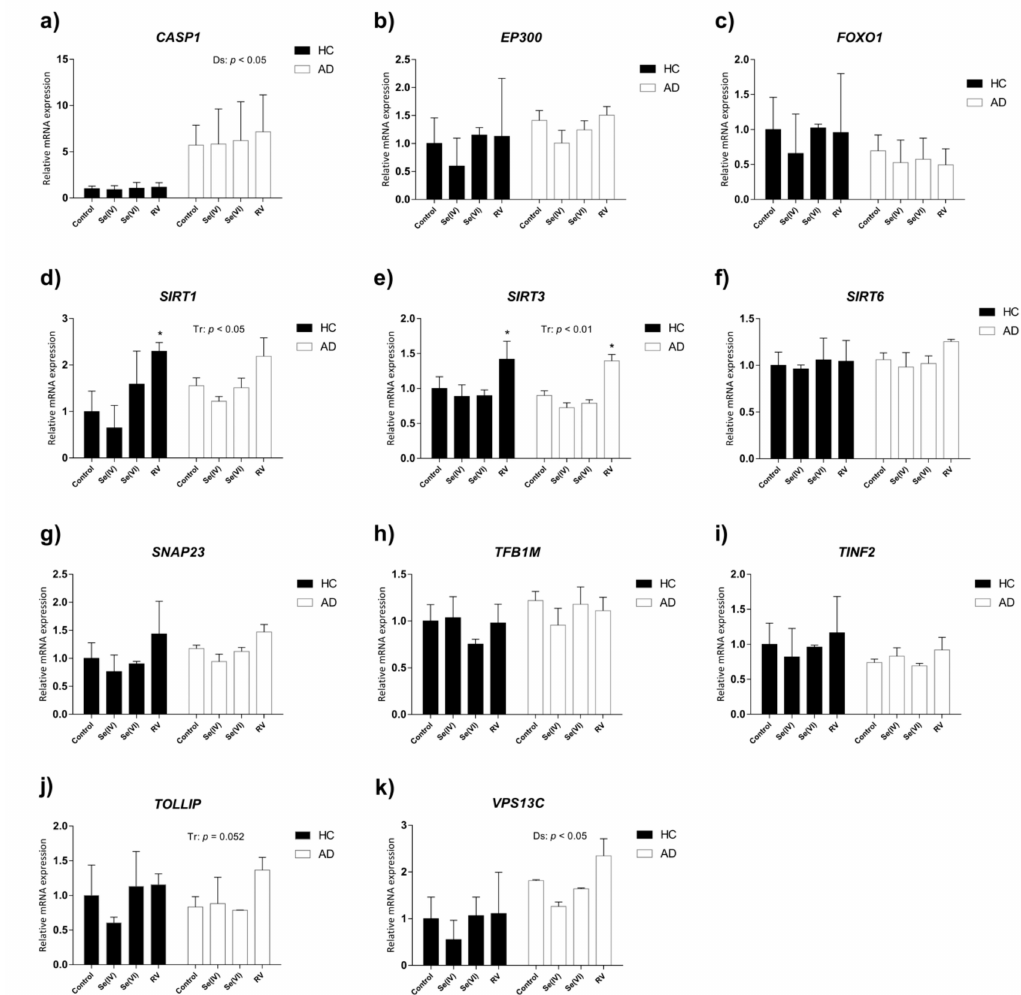
Figure 4. Relative expression of age-related genes in AD and HC lymphoblast cell lines treated with selenite (Se (IV)), selenate (Se (VI)), and resveratrol (RV). Gene expression analysis by real-time PCR from lymphoblast mRNA using TaqMan FAM-labeled specific probes and normalized with the mean of both housekeeping genes: phosphoglycerate kinase 1 ( PGK1 ) and beta-2-microglobulin ( B2M ). ( a ) Caspase 1 ( CASP1 ); ( b ) E1A binding protein p300 ( EP300 ); ( c ) forkhead box O1 ( FOXO1 ); ( d ) sirtuin 1 ( SIRT1 ); ( e ) sirtuin 3 ( SIRT3 ); ( f ) sirtuin 6 ( SIRT6 ); ( g ) synaptosome associated protein 23 ( SNAP23 ); ( h ) transcription factor B1, mitochondrial ( TFB1M ); ( i ) TERF1-interacting nuclear factor 2 ( TINF2 ); ( j ) vacuolar protein sorting 13 homolog C ( VPS13A ). P -values for two-way ANOVA are indicated at the top or on the right. Tr: treatment e ff ect; Ds: disease e ff ect. P -values of Fischer’s LSD post hoc test for each group (relative to control treatment) are indicated as: * p < 0.05. Values are mean ± SEM of two to four independent experiments with n = 2 / experiment on two di ff erent cell lines per group. HC and AD stand for healthy control and Alzheimer’s disease,